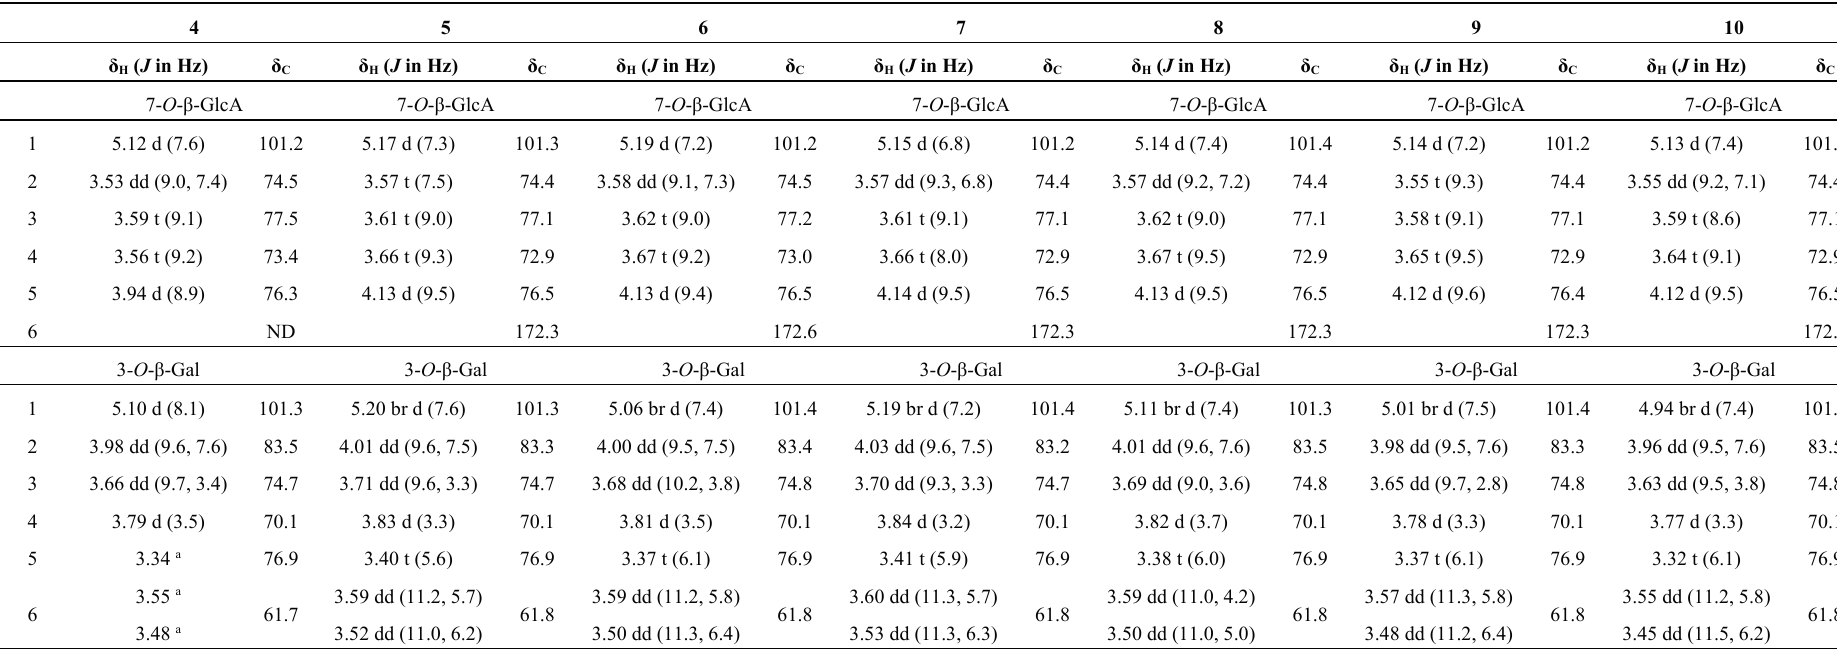
Table 3. NMR spectroscopic data (methanol- d 4 , 500 MHz) for the sugar and phenolic acid units of compounds 4 – 10